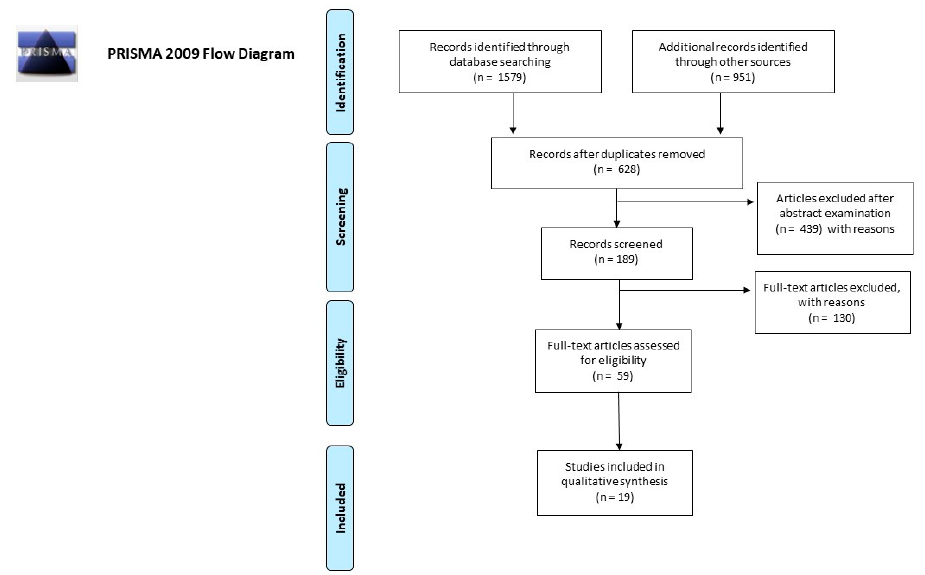
Figure 1. Preferred Reporting Items for Systematic Reviews and Meta-Analyses (PRISMA) 2009 flow diagram.